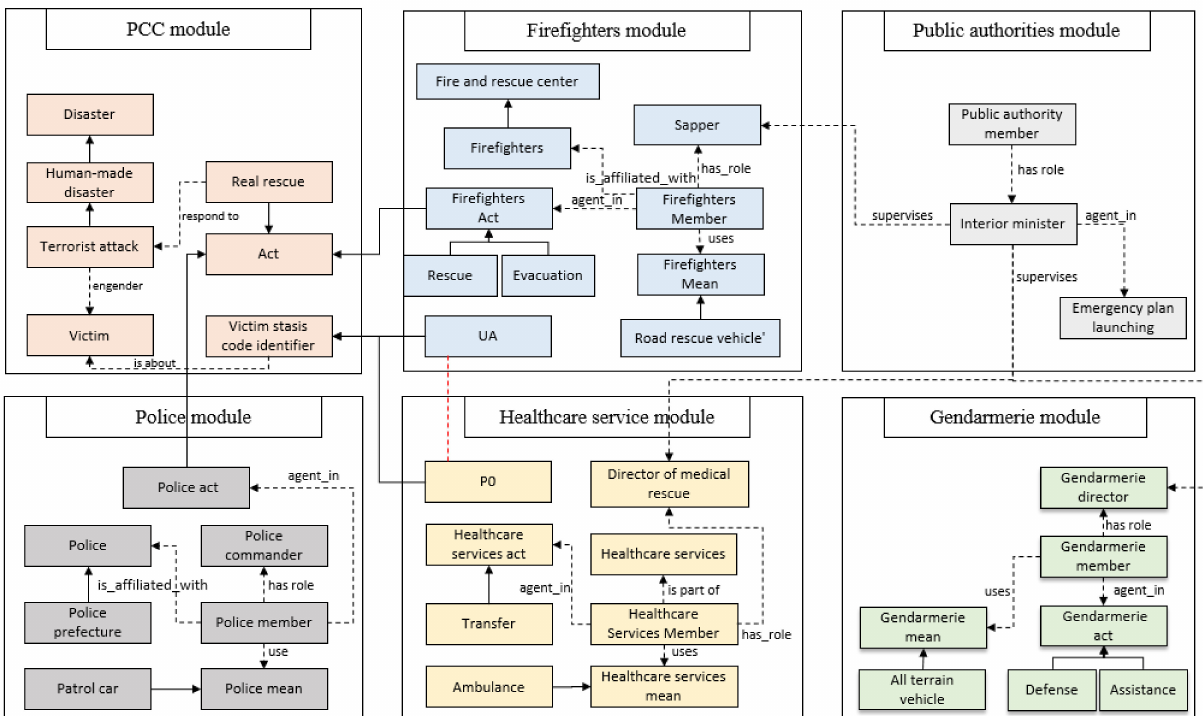
Figure 14. Partial view of stakeholders’